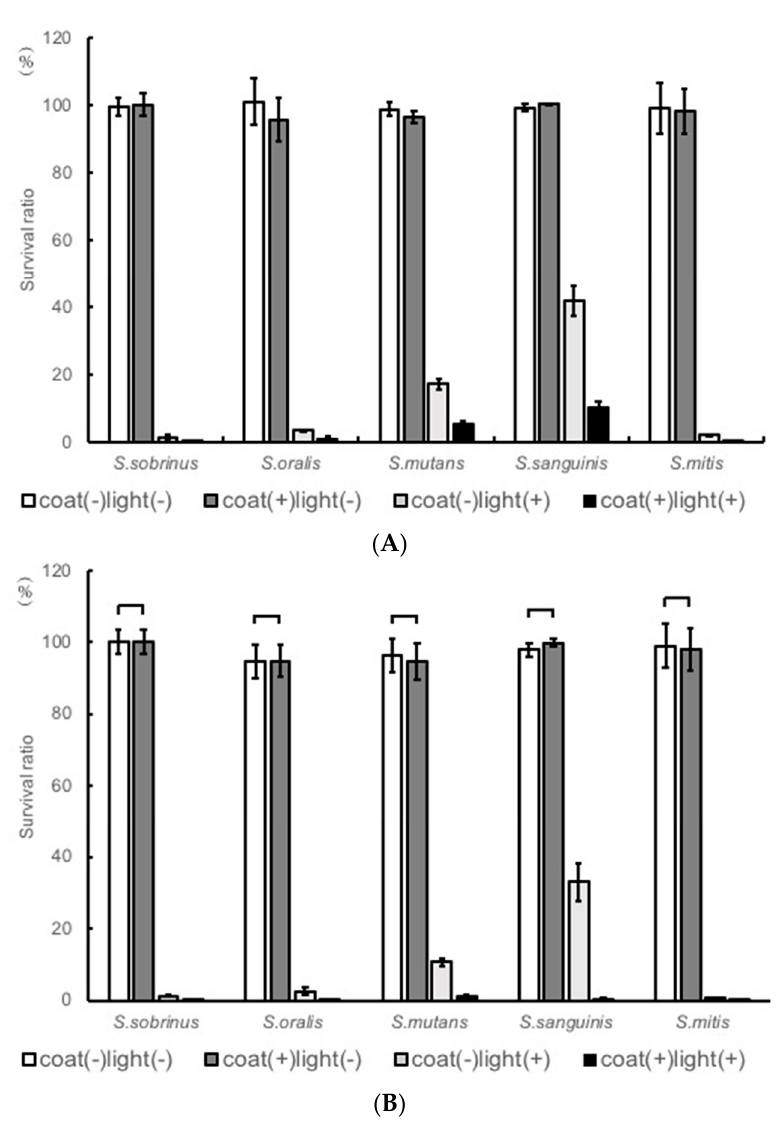
Figure 2. Antibacterial effects on various specimens of Streptococcus sobrinus , Streptococcus oralis GTC, Streptococcus mutans , and Streptococcus sanguinis at ( A ) 90 min, and ( B ) 120 min of ultraviolet A (UVA) irradiation.